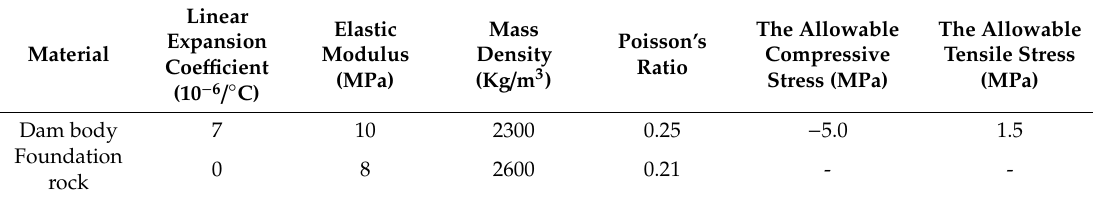
Table 2. Properties of dam body and foundation rock.